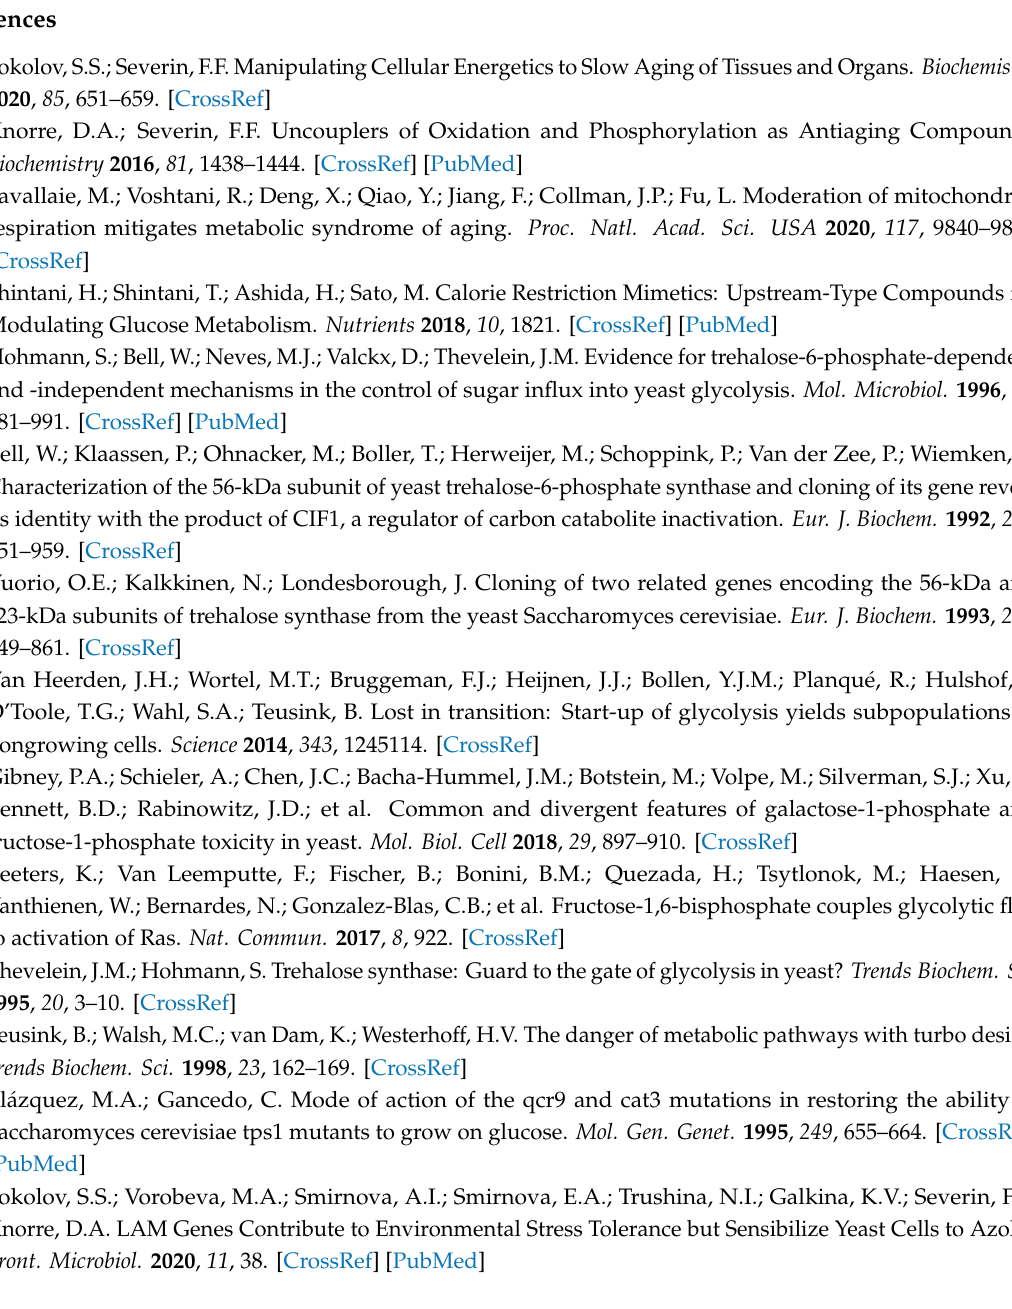
isolated mitochondria. Table S1: A list of chemicals tested for their ability to stimulate the growth of tps1-delta cells in the presence of